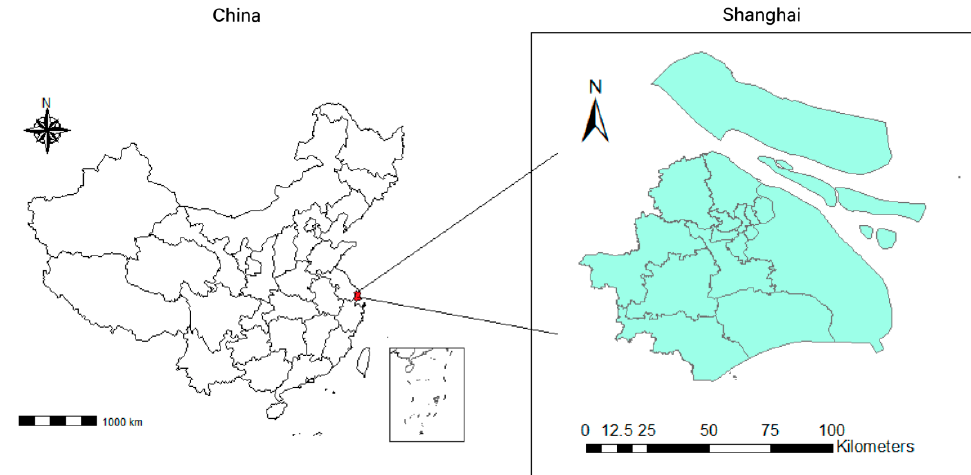
Figure 1. Location of Shanghai, China.